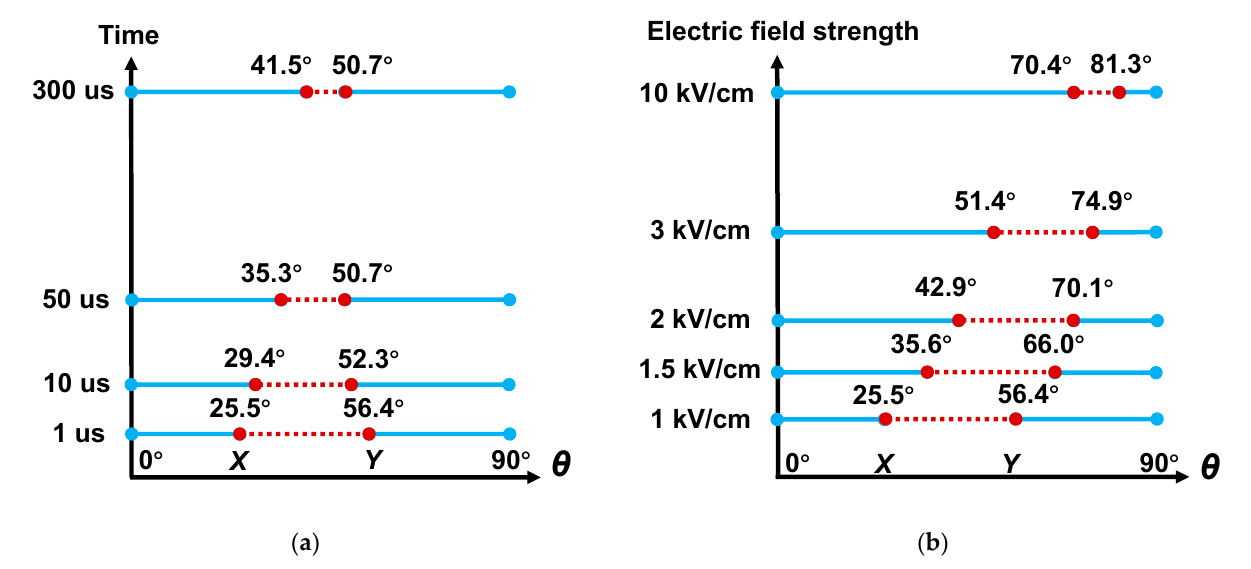
Figure 3. Two boundaries of the transition region, X and Y, shift with ( a ) time and ( b ) electric field strength.